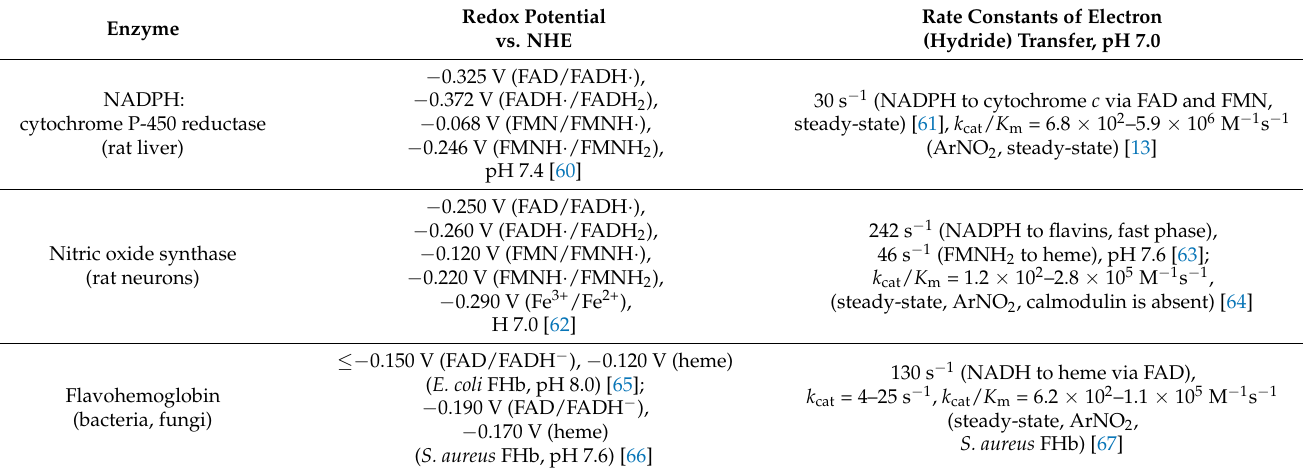
Table 1. Potentiometric and kinetic characteristics of heme-reducing flavoenzymes and flavohemoproteins. Enzyme